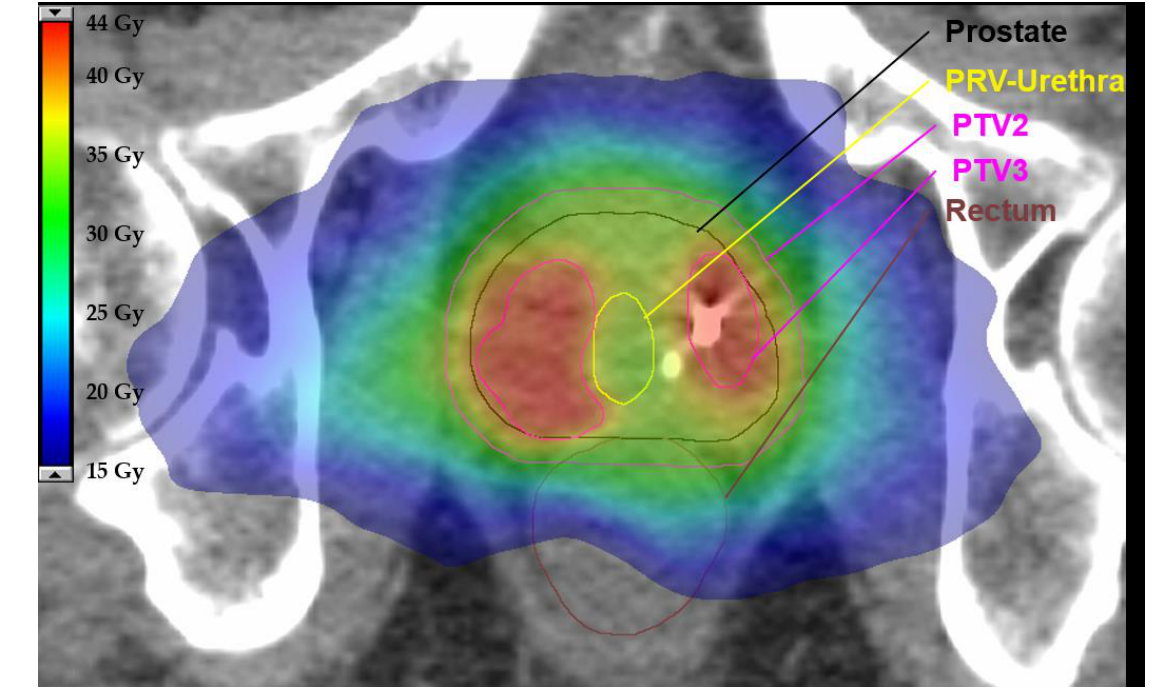
Figure 3. Exemplary axial slide of a representative plan using stereotactic body radiotherapy (SBRT) for the experimental arm. This example demonstrates how overlapping parts between the planning target volume (PTV) and planning organ at risk volume (PRV) are removed to define the final PTV. There is a steep dose gradient to spare the urethra while preserving a sufficient dose to the PTV. Relevant organ as risks, PTVs and isodoses in colorwash are illustrated according to the